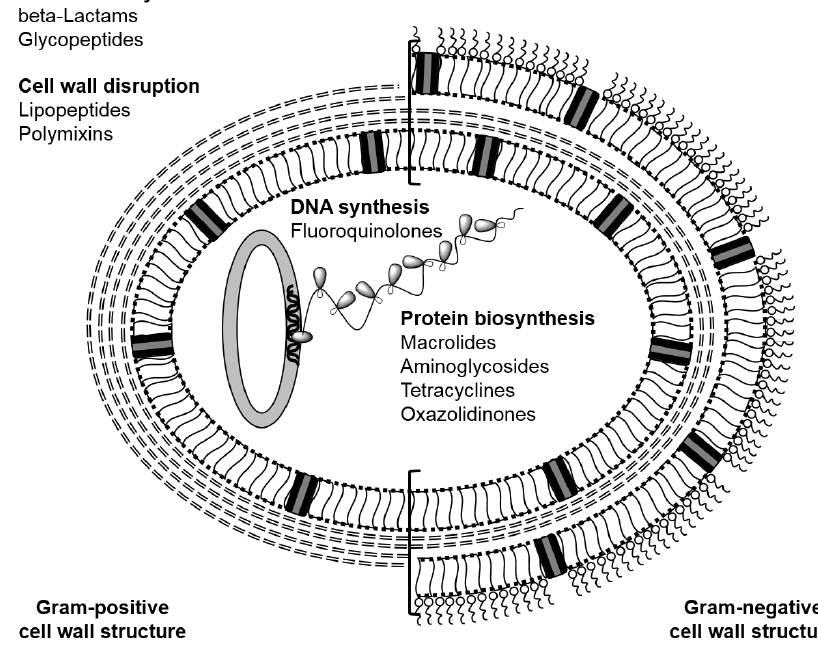
Figure 2. Common antibiotic classes and their targets.